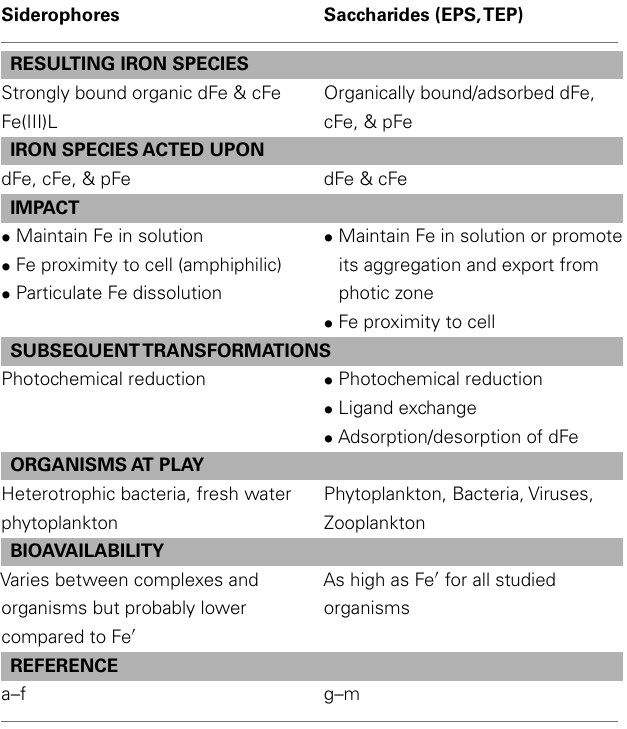
Table 3 |The influence of siderophore and saccharide release on iron chemistry and availability in aquatic